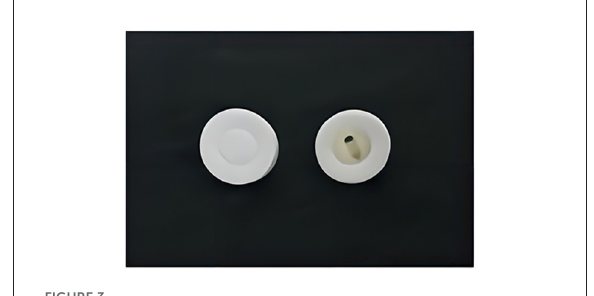
FIGURE3 Different types of appliance (left: non-hollow patch for sham acupuncture; right: hollow patch for real acupuncture).